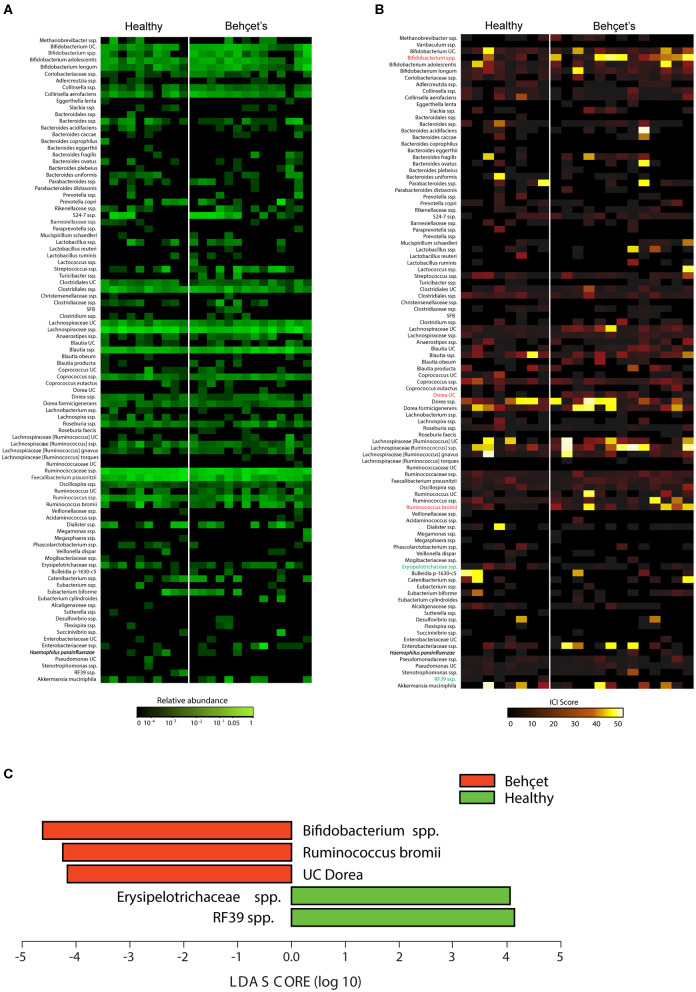
(A) Abundance heatmap: heatmap depicting relative abundance of bacterial species in fecal bacteria from BD patients (n = 13 samples) and HC (n = 8 samples). The relative abundance heatmap is depicted on a logarithmic scale. UC, unclassified in the Greengenes reference database. (B) IgA-Coating Index (ICI) heatmap: Heatmap depicting ICI scores of bacterial species in fecal bacteria from BD patients (n = 13 samples) and HC (n = 8 samples). Species that are significantly enriched in BD patients as compared to HC are depicted in red, species that are significantly IgA-coated in HC as compared to BD patients are depicted in green (LEfSe; p < 0.05). UC, unclassified in the Greengenes reference database. (C) Lefse plot: LEfSe comparisons of ICI scores of bacterial species from BD patients and HC. Taxa that are significantly enriched in BD patients are depicted in red, and taxa that are significantly enriched in the healthy controls are depicted in green. Significance levels for LEfSe were p < 0.05 and Linear Discriminant Analysis (LDA) Score > 2.